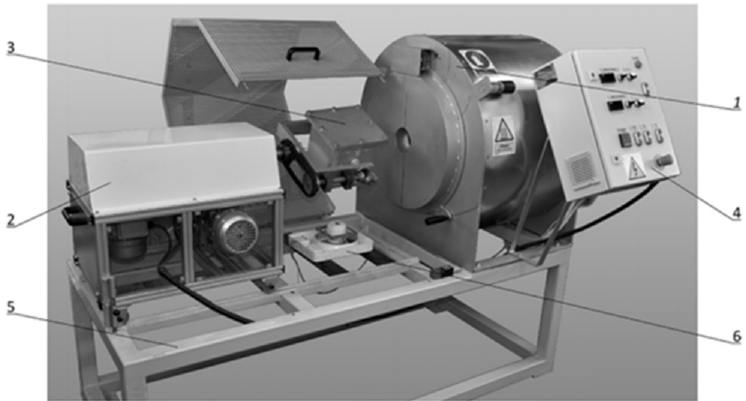
Figure 5. Laboratory machine for rotational moulding: 1—heating system, 2—rotational system, 3—mould, 4—control and regulation system, 5—base, 6—fan.